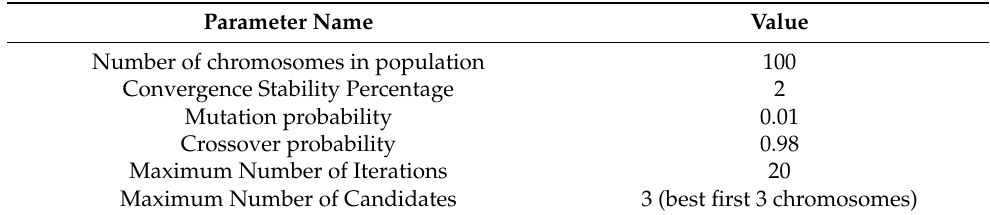
Table 4. Genetic algorithm